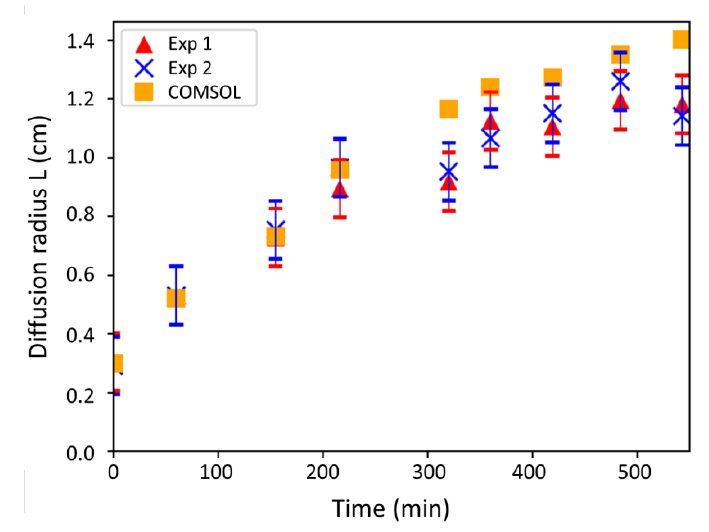
Figure 2. Comparison of the diffusion radii obtained by the model and the experiments: results over time. over